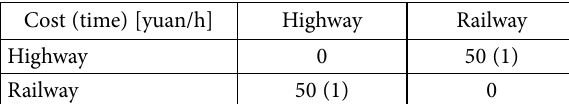
Table 5. Average transfer costs and time of different transportation modes